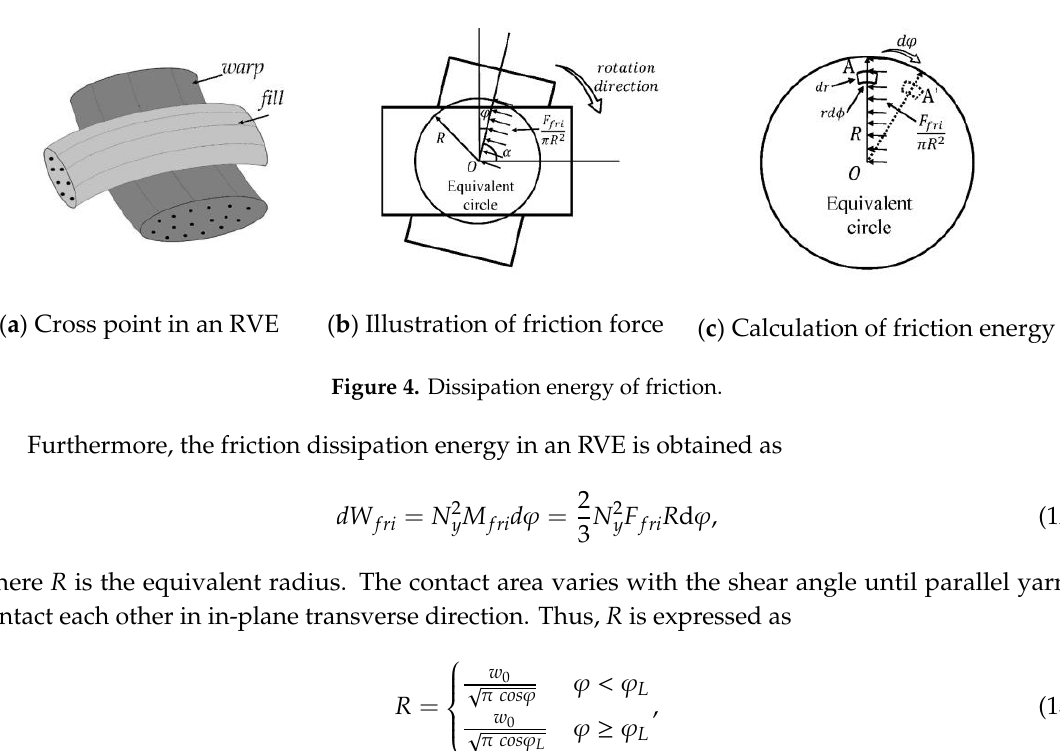
Figure 6. The contact force produced by the tension force of a yarn (different weave pattern).